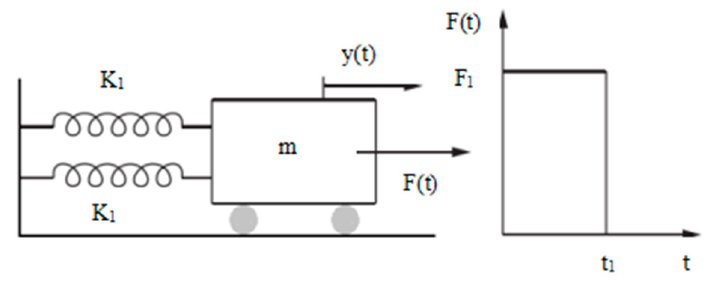
Figure 5. The nonlinear oscillator. Table 4. Distribution parameters of the random variables of Example 3.